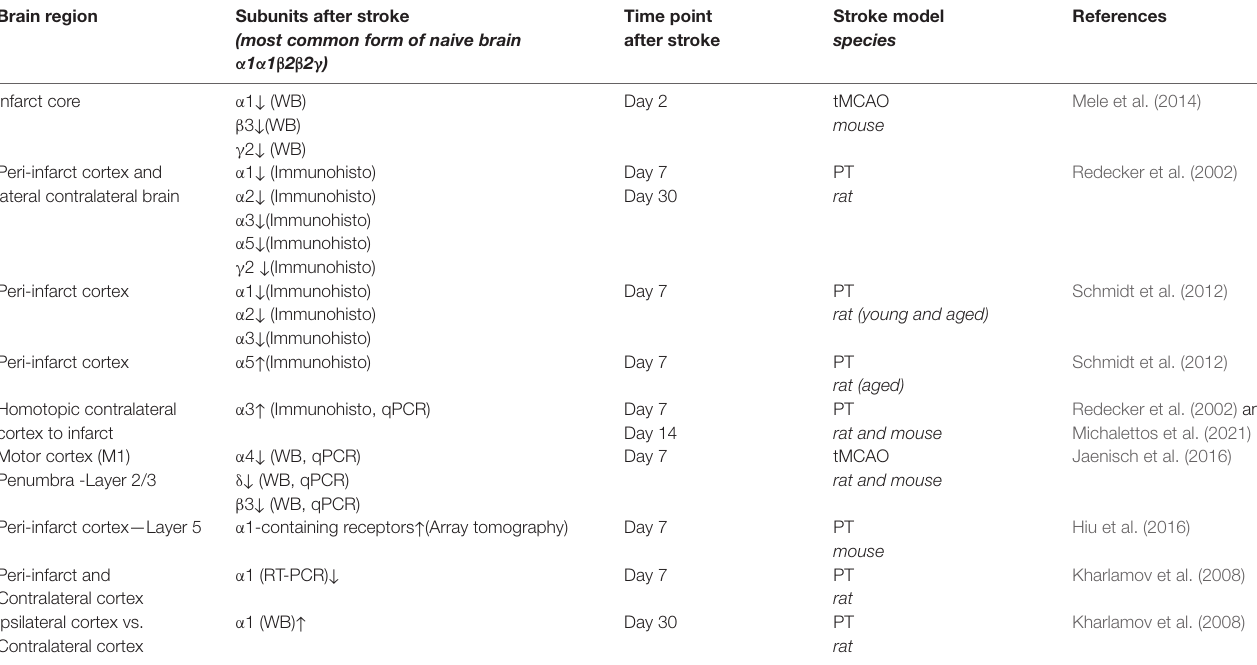
TABLE 1 | Changes of GABA A receptor subunita expression in rodent models of stroke. Brain region Subunits after stroke (most common form of naive